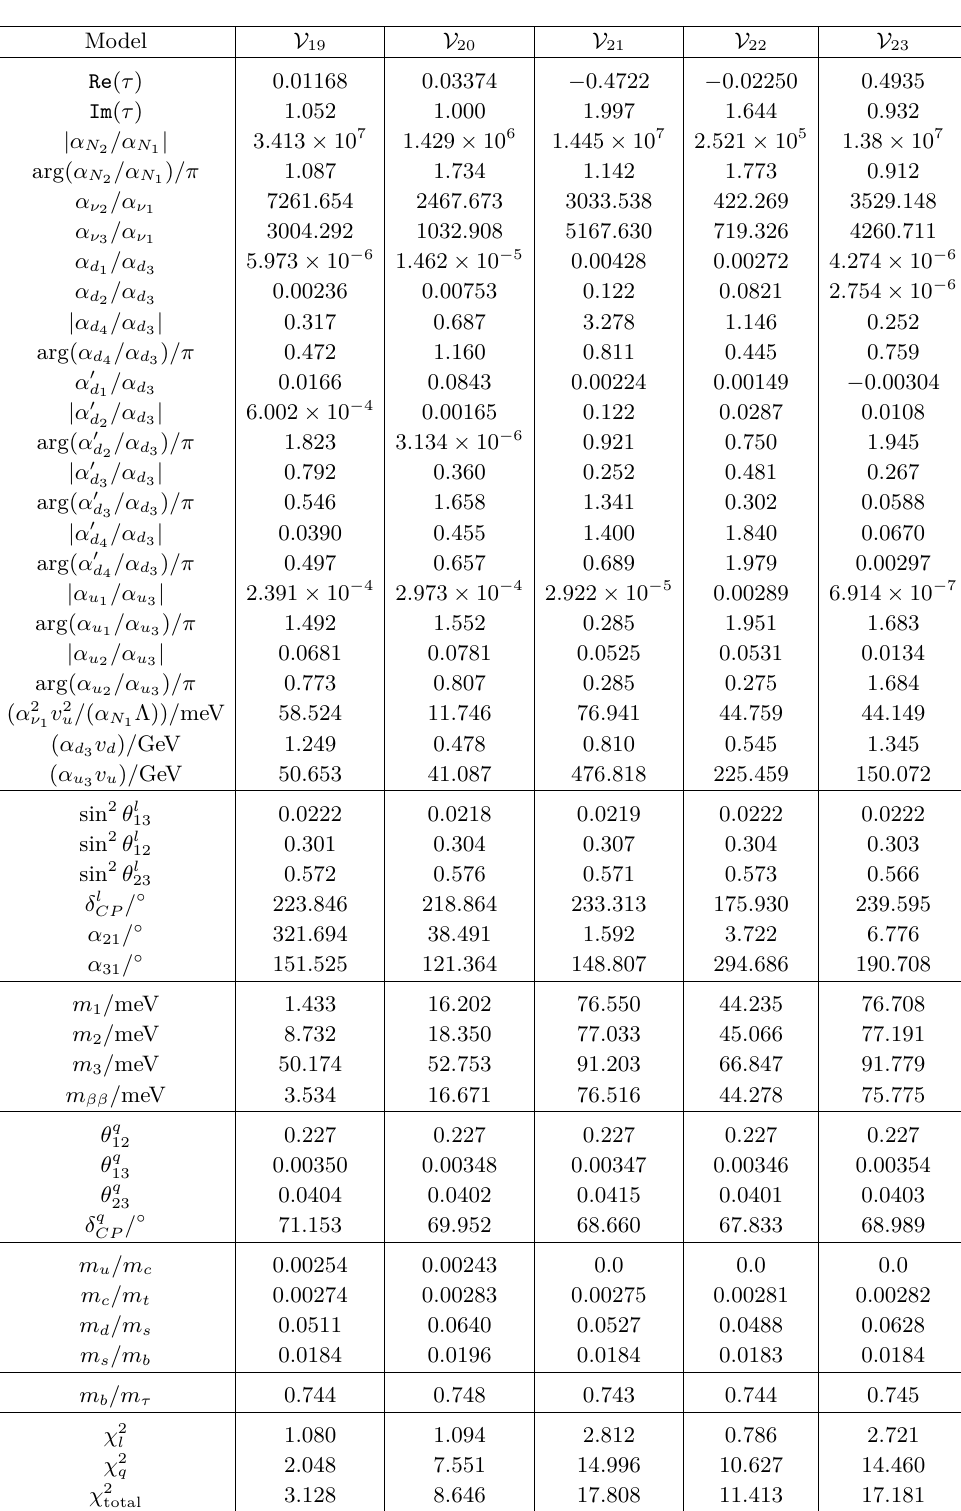
Table 13 . The best fit values of the free parameters and the corresponding predictions for lepton and quark mixing parameters and fermion masses for the phenomenologically viable models of Type-V (continuation of table